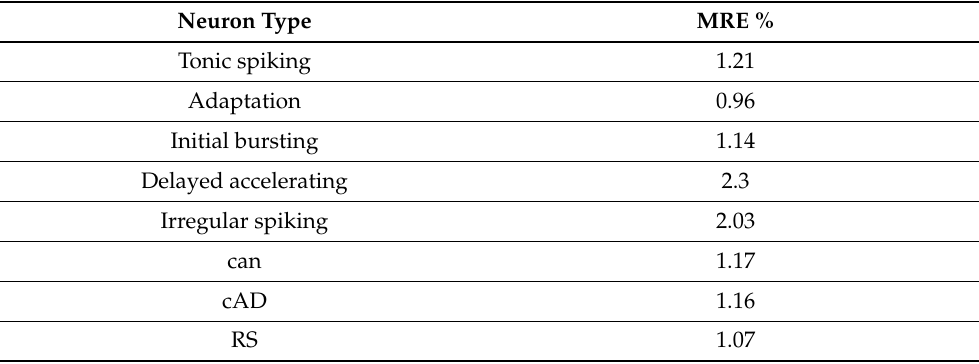
Figure 7. Time differences between spiking patterns of the original and proposed ADEX models. Table 6. Mean relative error for all spiking patterns in the proposed